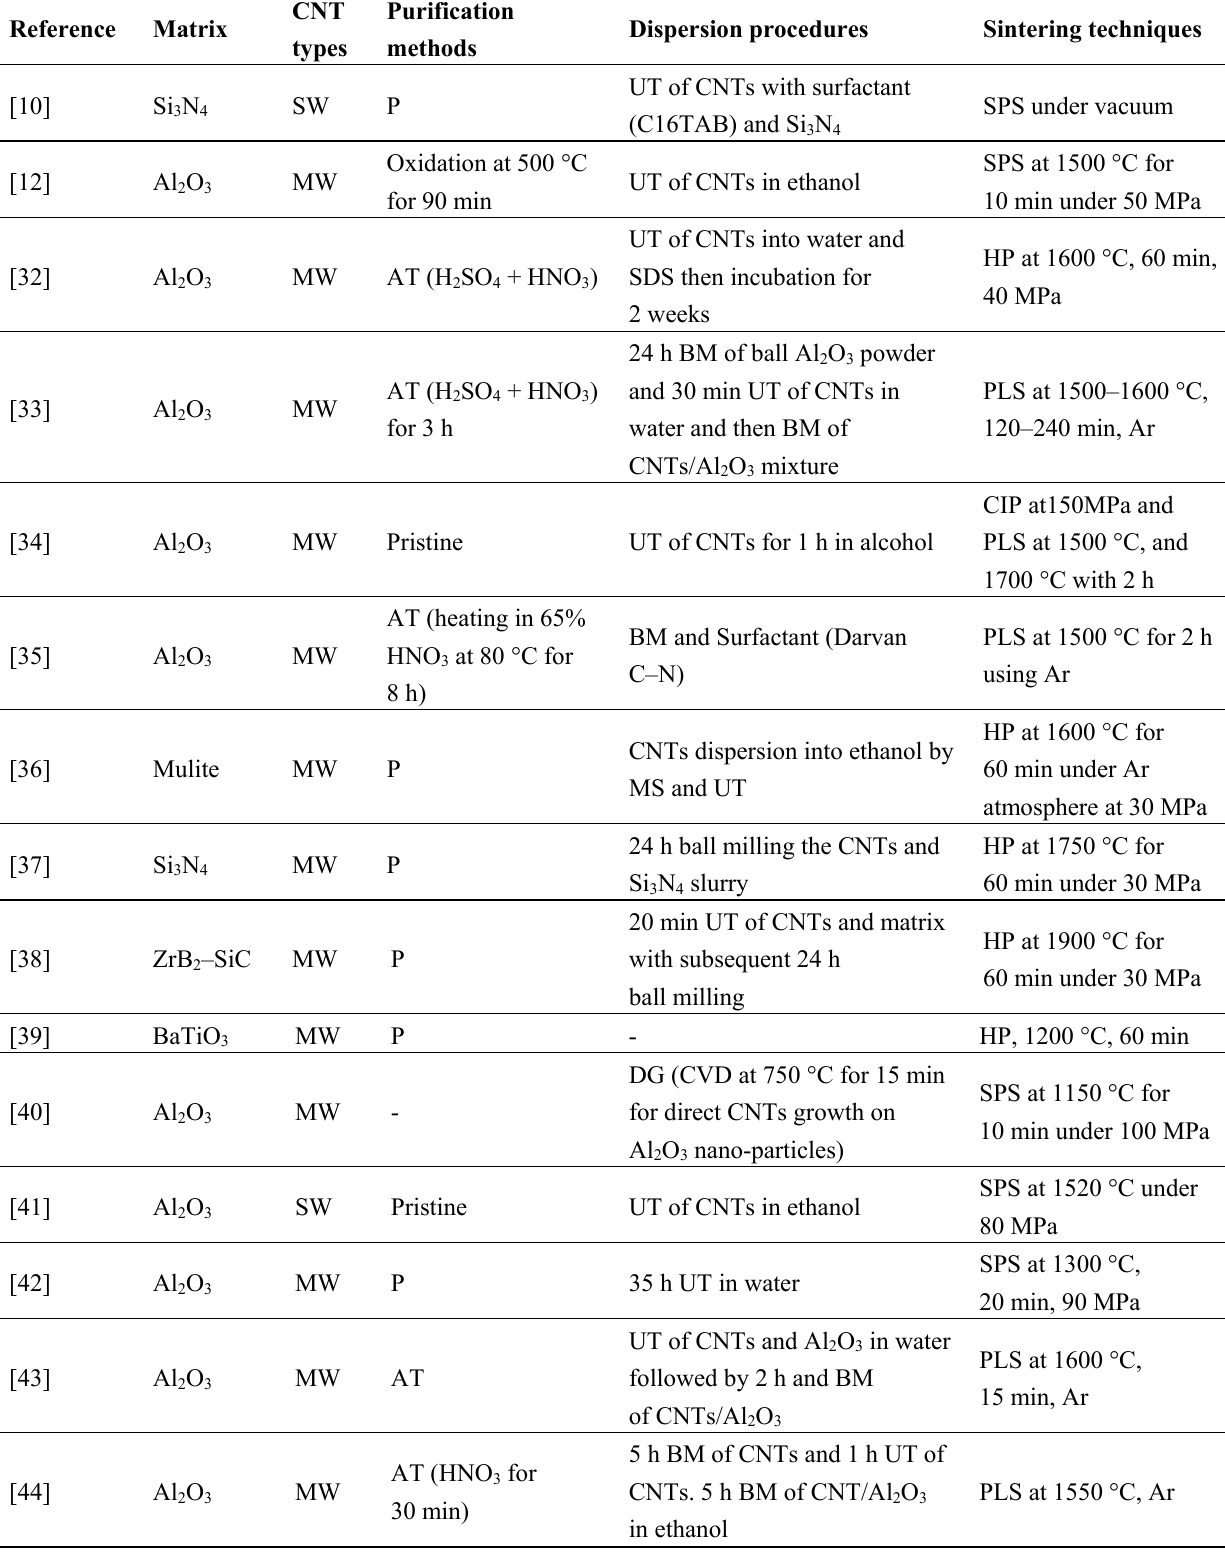
Table 1. Processing details of CNTs-reinforced ceramics